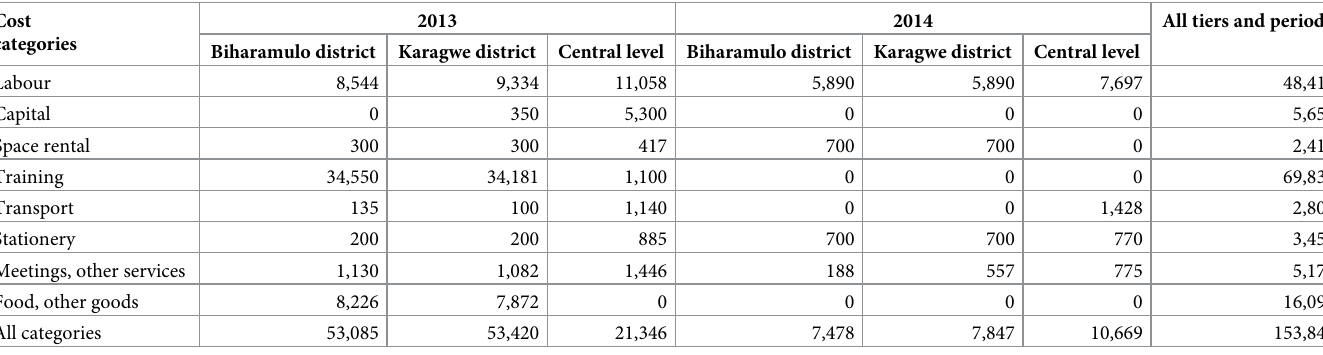
Table 2. CGLAS: Summary of costs of the paralegal programme, by year, location, and category. Cost